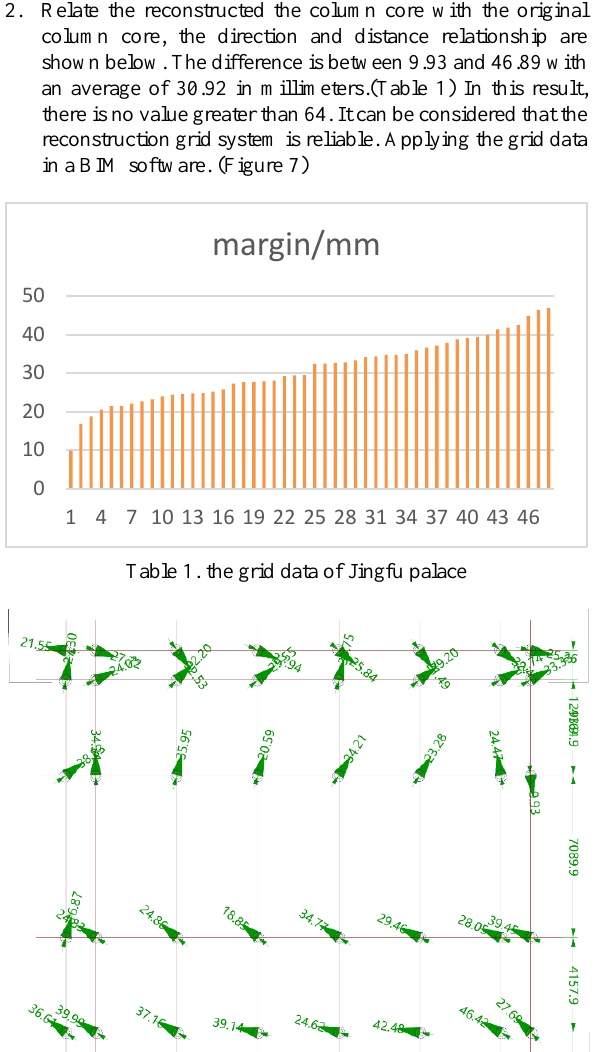
Figure 6. reconstruction grid system of Jingfu